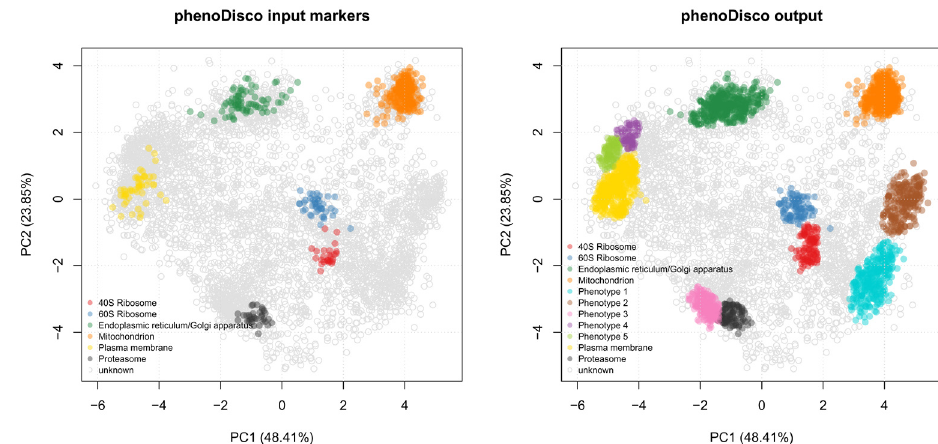
Figure 14. Results of the novelty detection